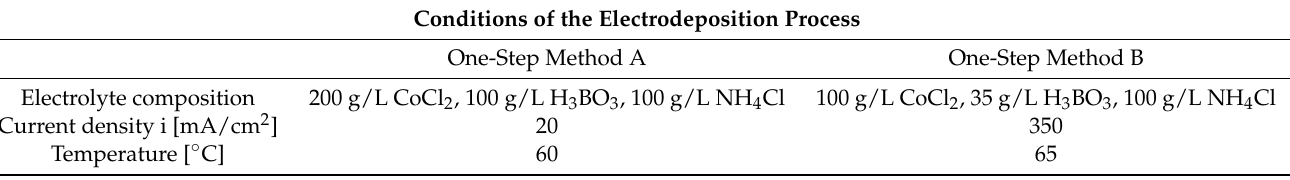
Table 3. New conditions of the electrodeposition process in one-step method B. Conditions of the Electrodeposition Process One-Step Method